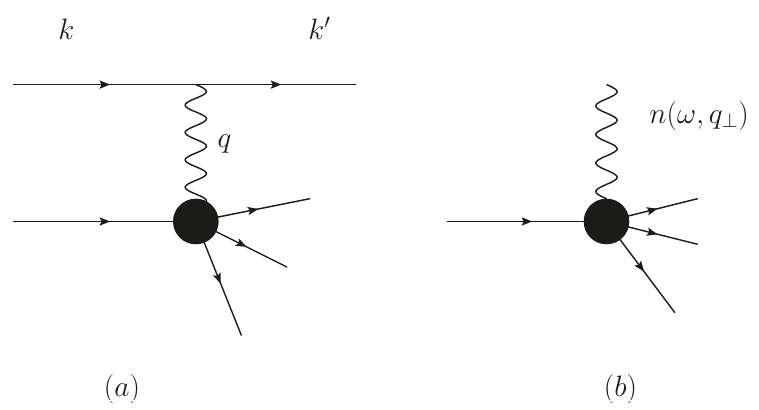
Figure 21 . The idea of the equivalent photon approximation. If a charge with the momentum k , emitting the virtual photon with the virtuality q , is ultrarelativistic, then the cross section of the process (a) can be expressed in terms of the cross section of the process (b). The remained e(cid:11)ect of the charge is the distribution function n charge ( x; q 2 ), where x is the energy fraction carried by